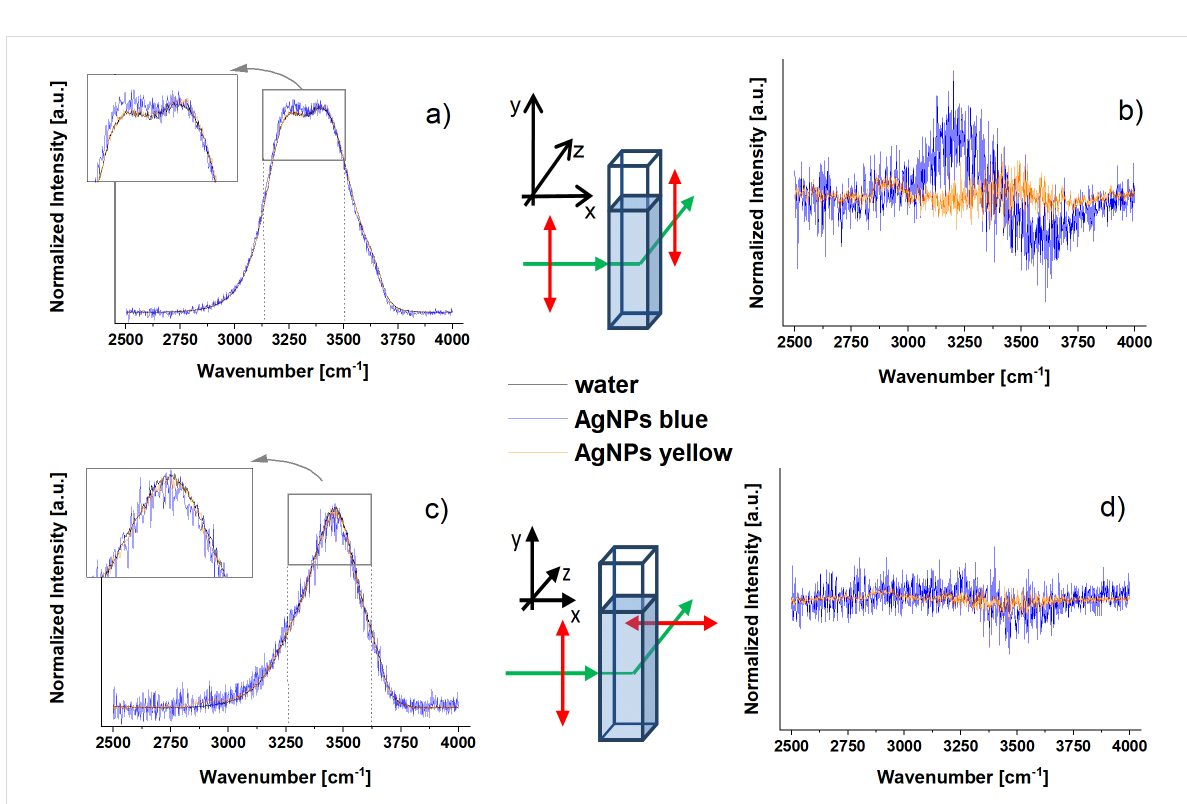
Figure 2: Polarised Raman spectra in the OH stretching vibration region for pure water and two AgNPs dispersions acquired with parallel (a) and per- pendicular (c) configurations, respectively. Panels (b) and (d) show differential spectra of AgNPs relative to the water spectrum. The inserts show a spectral region zoomed in on the maxima of the OH stretching